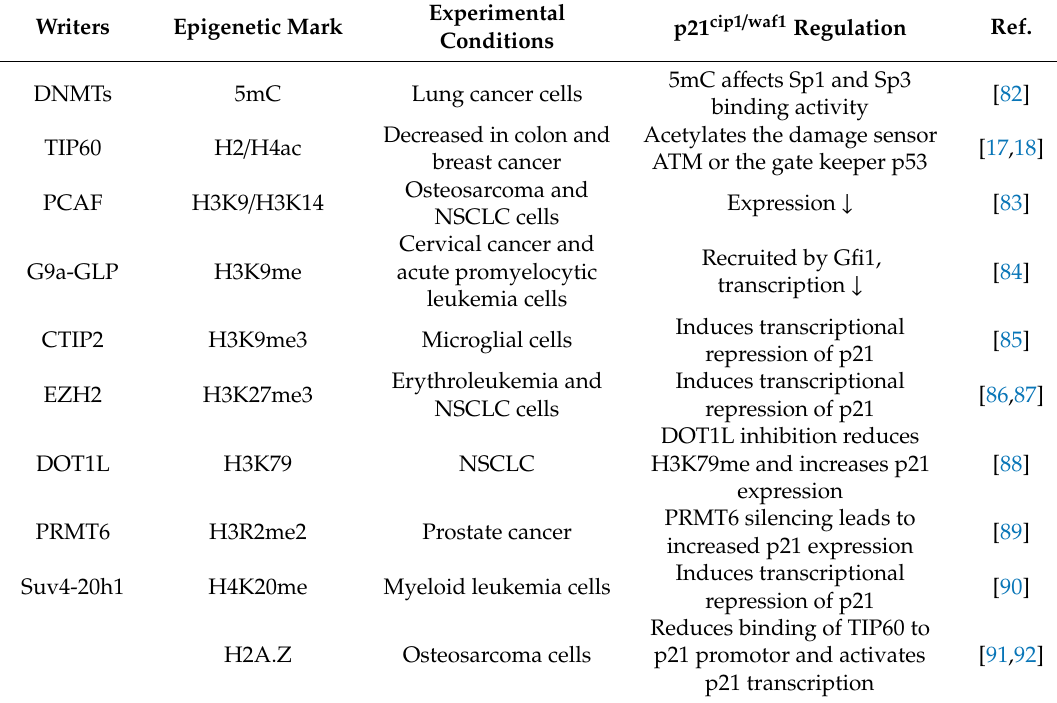
Table 1. Overview of p21 cip1 / waf1 regulation by epigenetic